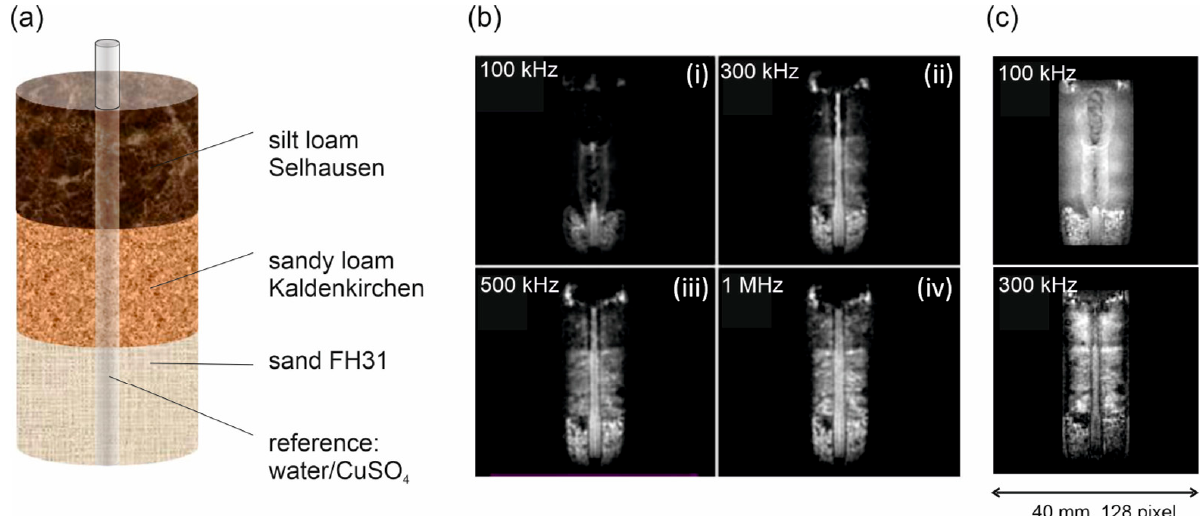
Figure 4. Imaging a composite soil sample S2 with UTE and ZTE. ( a ) Sketch of the phantom. ( b ) UTE images of coronal cross-sections showing the three soil materials and the marker tube in the center. Matrix size and resolution are 128 3 and isotropic 0.31 mm, respectively. Increasing the receiver bandwidth (reduction of acquisition time) from 0.1, 0.3, 0.5, to 1.0 MHz decreased T 2 * blurring artefacts especially for the silt loam soil material. ( c ) ZTE Images: Increasing the receiver bandwidth from 100 to 300 kHz reduced the T 2 * blurring and improved the image